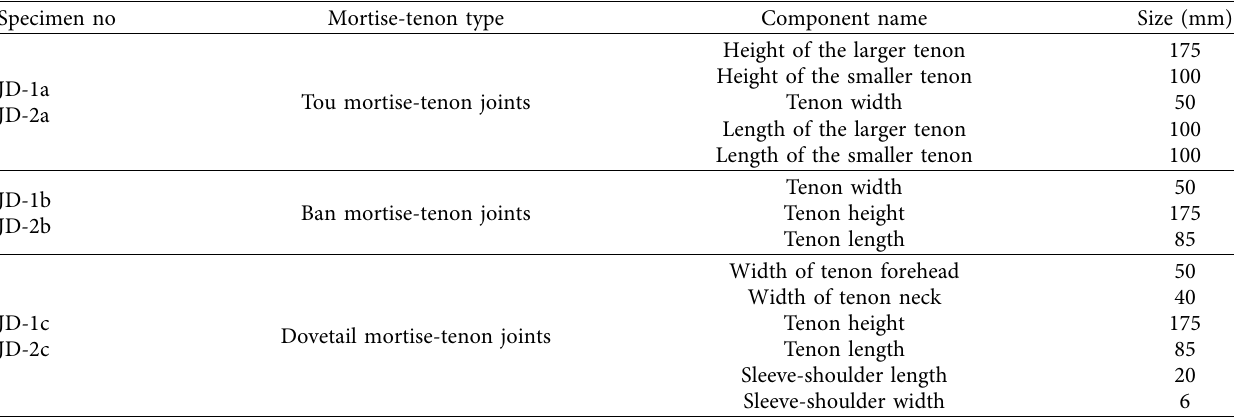
Table 1: Sizes of mortise-tenon.